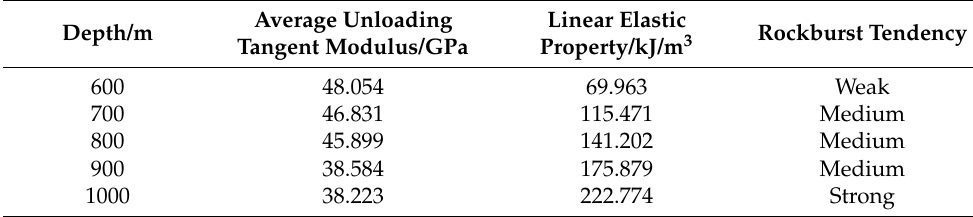
Table 4. Rockburst tendency based on linear elastic energy [25,26].